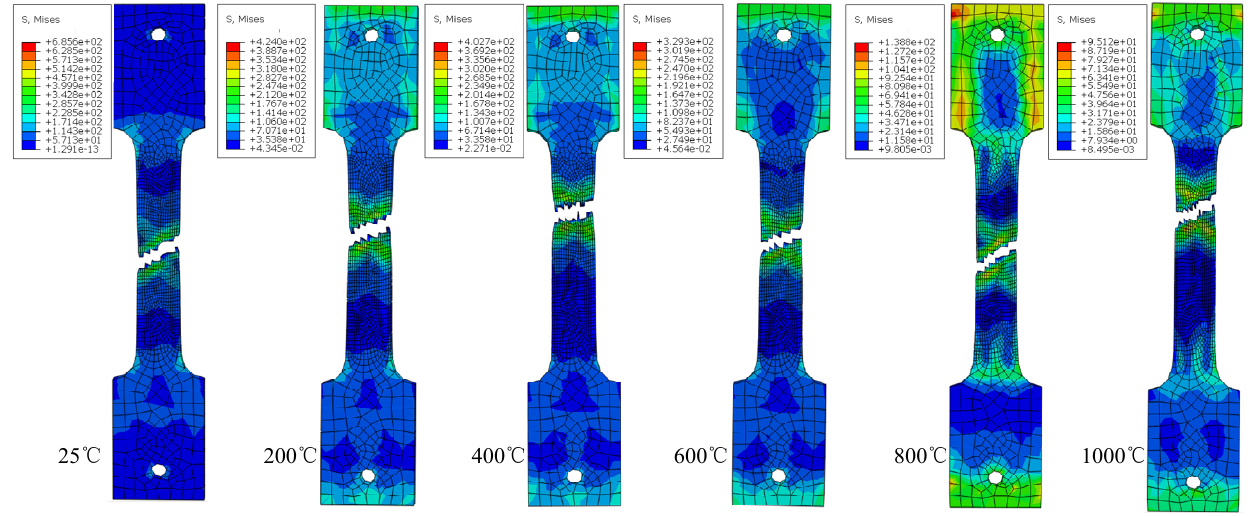
Figure 10. 316L high temperature tensile test simulation cloud diagram.